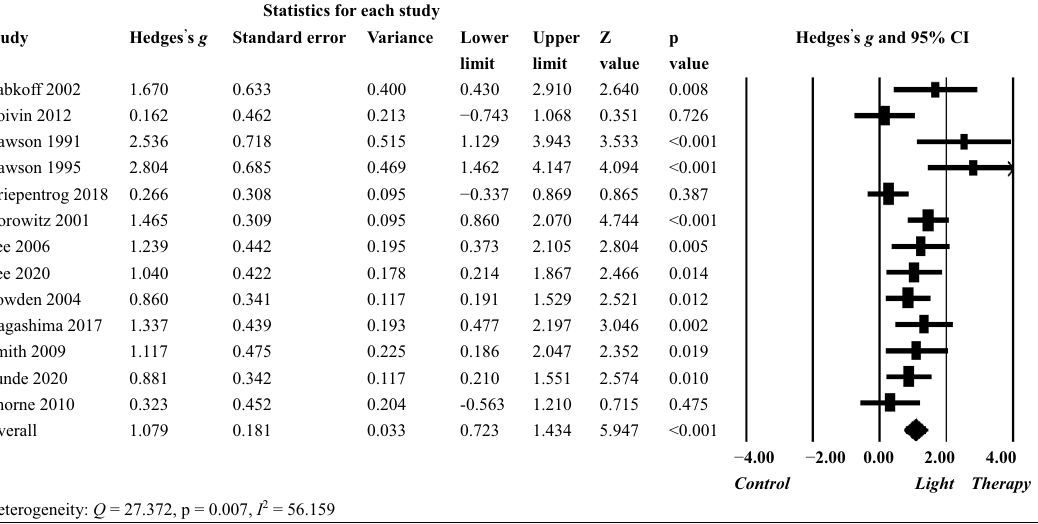
Figure 3. Treatment effect of light therapy on phase shift in shift workers analyzed using a random-effects total ≤ 10 h (g = 0.532, 95% CI = 0.361–0.703, p < 0.001) and treatment duration in total > 10 h (g = 0.309, 95% CI = 0.095–0.523, p = 0.005). A relatively higher effect size was associated with a higher number of daily treatment session: session > 1 (g = 0.535, 95% CI = 0.261–0.809, p < 0.001) and session = 1 (g = 0.400, 95% CI = 0.240–0.560, p < 0.001). However, continuous moderators of lux hours, light intensity, treatment duration, mean age, percent- age of female participants, and sample size on sleepiness were not found to be significant in metaregression analyses (all p > 0.05, Table 7). These results suggest nonlinear effects and potential saturation of light intensity (medium lux) and treatment duration (lower duration) for achieving a more favorable effect of light therapy on sleepiness, whereas a higher number of treatment sessions was more effective. The dose–response effect of light therapy on phase shift was significantly associated with different subgroups of light intensity, treatment duration, and number of daily treatment sessions (Table 6a). Higher to lower effect sizes were associated with high, medium, and low light intensity when light intensity was grouped as follows: (1) > 5000 lux (g = 2.676, 95% CI = 1.705–3.648, p < 0.001), 1000–5000 lux (g = 0.983, 95% CI = 0.611–1.356, p < 0.001), and < 1000 lux (g = 0.944, 95% CI = 0.423–1.465, p < 0.001); (2) > 5000 lux (g = 2.676, 95% CI = 1.705–3.648, p < 0.001), 2000–5000 lux (g = 1.134, 95% CI = 0.829–1.440, p < 0.001), and < 2000 lux (g = 0.677, 95% CI = 0.199–1.154, p = 0.005); and (3) > 5000 lux (g = 2.676, 95% CI = 1.705–3.648, p < 0.001), 3000–5000 lux (g = 1.204, 95% CI = 0.853–1.555, p < 0.001), and < 3000 lux (g = 0.710, 95% CI = 0.362–1.058, p < 0.001). A higher effect size was associated with a longer daily treatment duration: > 1 h (g = 1.166, 95% CI = 0.688–1.644, p < 0.001) and ≤ 1 h (g = 0.952, 95% CI = 0.206–1.698, p = 0.012). However, a slightly higher effect size was associated with a shorter total treatment duration: ≤ 10 h (g = 1.182, 95% CI = 0.865–1.499, p < 0.001), and > 10 h (g = 1.166, 95% CI = 0.282–2.050, p = 0.010). A slightly higher effect size was associated with a fewer number of daily treatment session: session = 1 (g = 1.137, 95% CI = 0.607–1.667, p < 0.001) and session > 1 (g = 1.130, 95% CI = 0.627–1.633, p < 0.001). Significant effects of continuous moderators on phase shift were observed in metaregression analyses (Table 7): lux hours (coefficient = 0.014, 95% CI = 0.004–0.024, p = 0.008), light intensity (coefficient = 0.286, 95% CI = 0.061–0.512, p = 0.013), and mean age (coefficient = − 0.052, 95% CI = − 0.092 to − 0.013, p = 0.009); however, the effects were not significant for the percentage of female participants and sample size (all p > 0.05). These results suggest a positive association between higher light intensity and better light therapy effect on phase shift, and fewer treatment sessions were slightly more beneficial. However, the effect of treatment duration on phase shift was inconclusive. The effect of lux hours was lower than that of light intensity. These results indicat that the treatment duration did not exert a positive effect on phase shift. Moreover, younger participants experienced better treatment effects on phase shift than did older participants. Moderator analyses of treatment settings and research design. For sleepiness, the treatment effect was significant in the following subgroups (Table 5b): (1) timing of treatment, nighttime (g = 0.427, 95% CI = 0.170–0.683, p = 0.001) and daytime or mixed (g = 0.431, 95% CI = 0.279–0.583, p < 0.001); (2) treatment day, same day (g = 0.575, 95% CI = 0.347–0.804, p < 0.001) and different day (g = 0.363, 95% CI = 0.203–0.522, p < 0.001); (3) type of treatment light, single type (g = 0.361, 95% CI = 0.228–0.494, p < 0.001) and mixed type